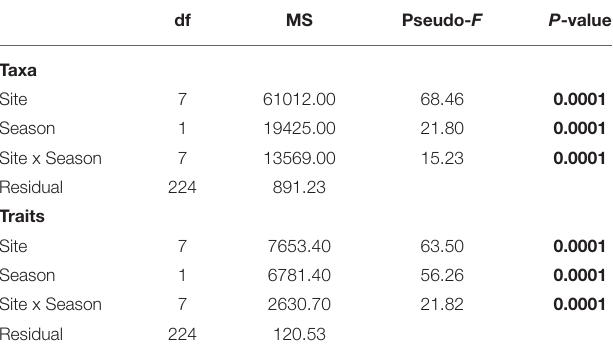
TABLE 7 | Test results from multivariate one-way fixed factor PERMANOVA to compare the community structure of taxa and traits composition across sites and